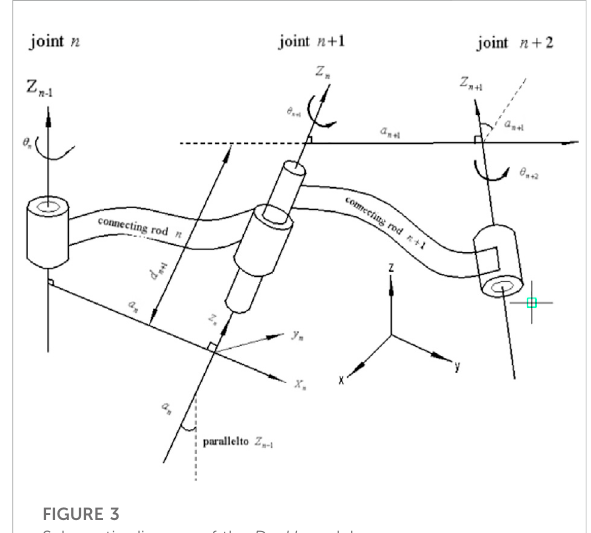
FIGURE 3 Schematic diagram of the D − H model.